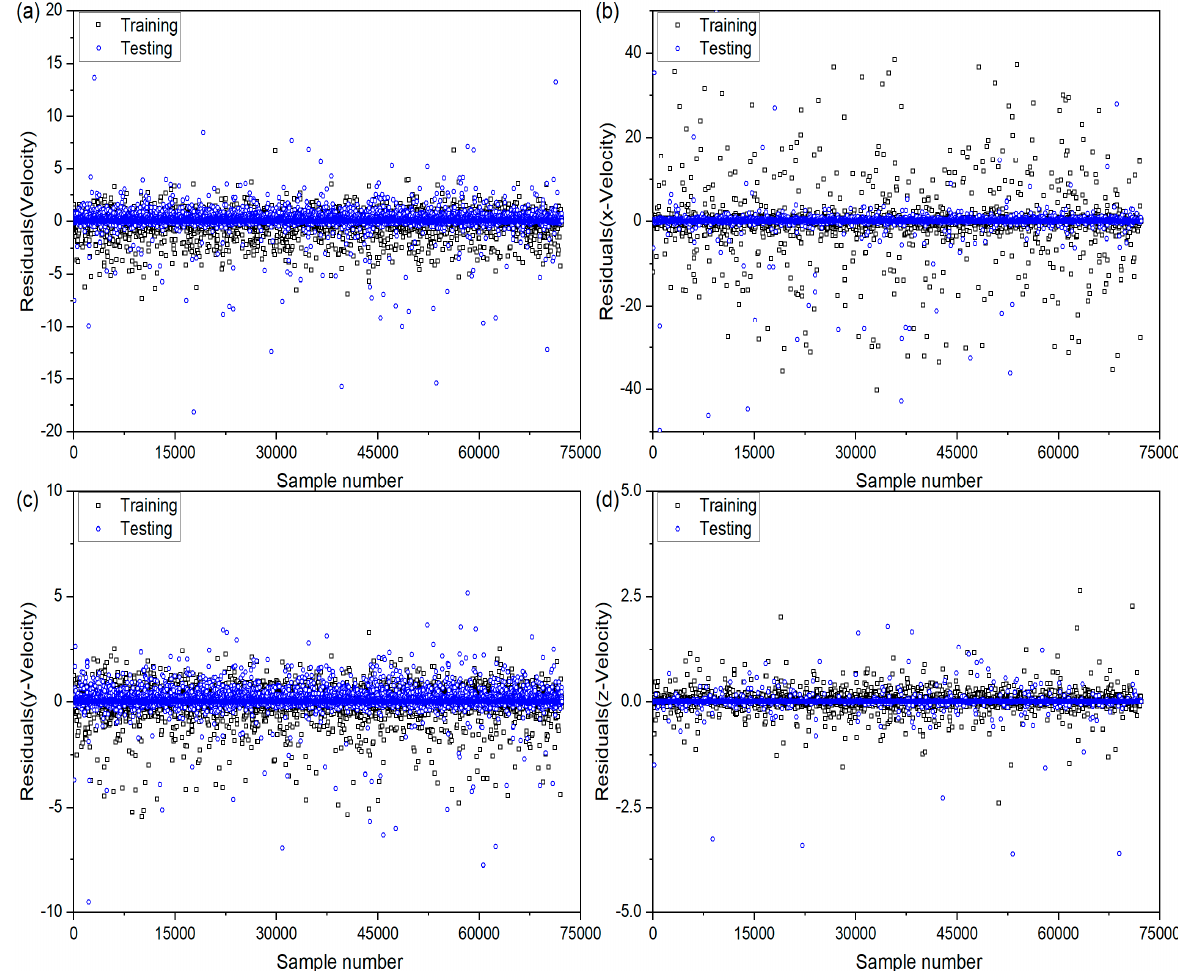
Figure 6. Prediction residuals while training and testing the RFR models for different target variables ( a ) velocity ( b ) x-velocity ( c ) y-velocity ( d ) z-velocity.